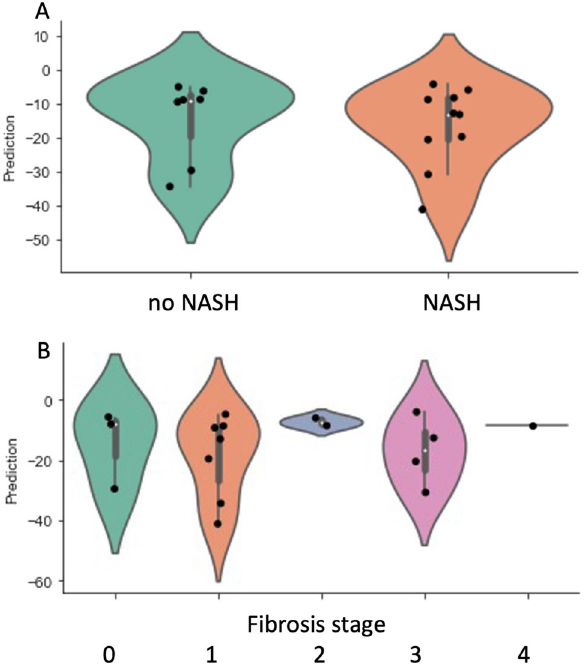
Figure 2. Violin plot showing the correlation between a previously published gene expression model and ( A ) NASH versus non-NASH, and ( B ) liver fibrosis stage. The y-axis (prediction) shows values calculated as the output of a published statistical model based on the expression of five genes in subcutaneous adipose tissue (CCL2, DMRT2, GADD45B, IL1RN, and IL8) 26